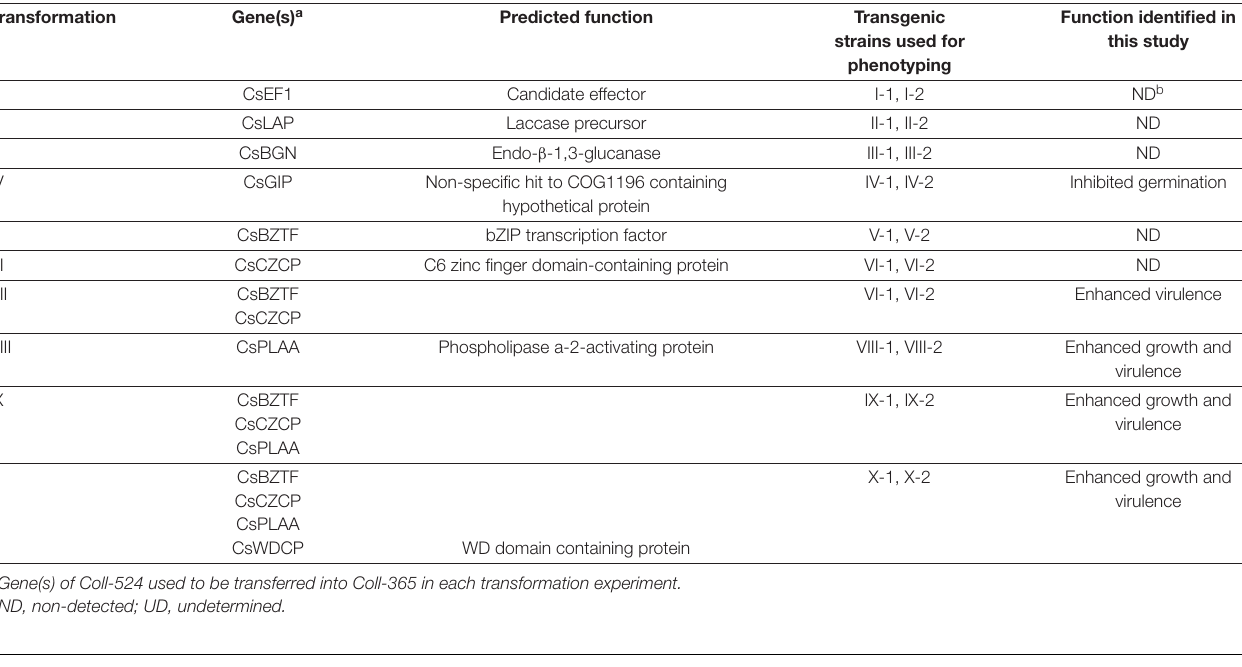
Function identified in strains used for this study phenotyping